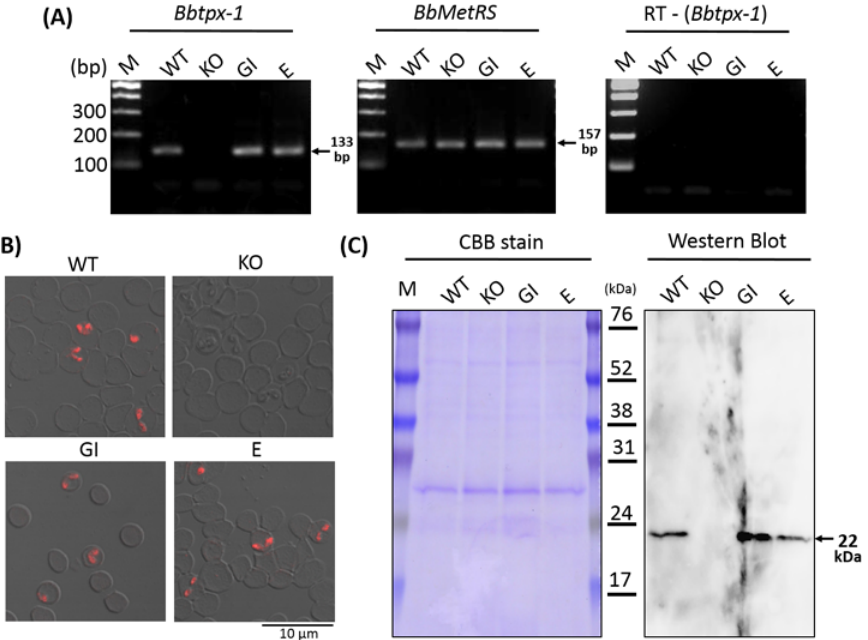
Fig 5. Validation of the BbTPx-1 expression in the transfectants. Expression of Bbtpx-1 in the wild type parental strain (WT), Bbtpx-1 KO parasites (KO), Bbtpx-1 genome integrant (GI), and Bbtpx-1 episomal transfectant (E). (A) RT-PCR assays were performed for Bbtpx-1 gene, methionyl-tRNA synthetase gene (BbMetRS), and a negative control without reverse transcription (RT — ( Bbtpx-1 )). M, 100 bp DNA ladder marker. Expected RT-PCR band size of 133 bp and 157 bp are indicated for Bbtpx-1 and BbMetRS , respectively. (B) Indirect immunofluorescence assay with anti-BbTPx-1 serum. Differential interference contrast and fluorescence images are merged. The red fluorescence in the cytoplasm of the complemented transfectants indicates expression of BbTPx-1. (C) Western blot analysis with anti-BbTPx-1 serum. A band was detected from WT, GI, and E, which is consistent to the expected size of BbTPx-1 protein of 22 kDa. The CBB staining image in the left panel shows equal